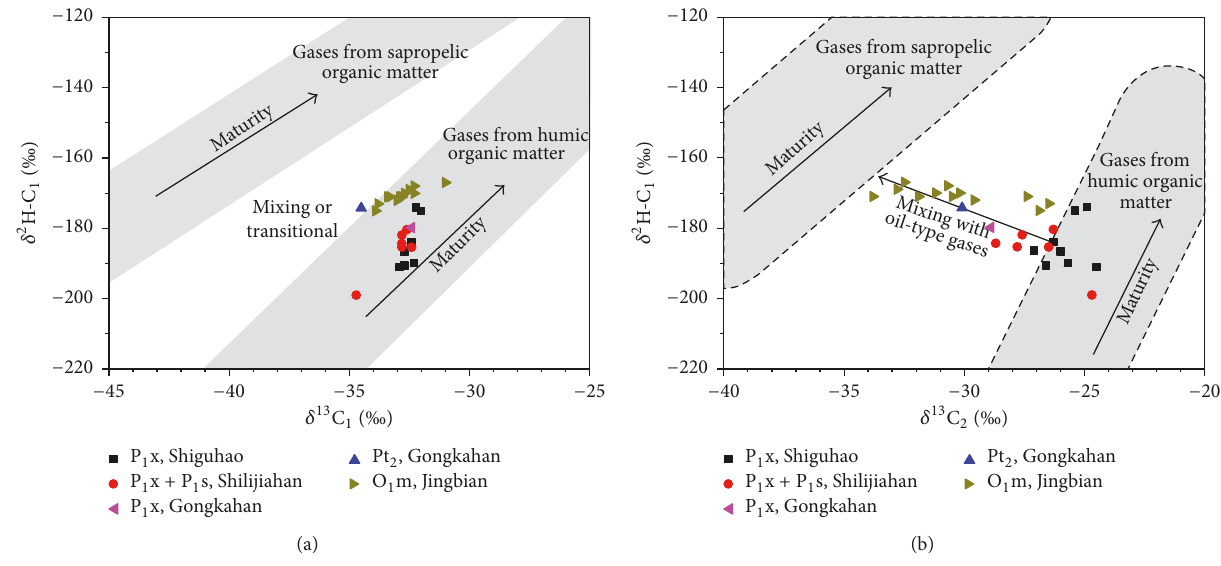
Figure 9: Correlation diagrams of 𝛿 2 H-C 1 versus 𝛿 13 C 1 (a) and 𝛿 2 H-C 1 versus 𝛿 13 C 2 (b) of tight gas from the Hangjinqi area (modified after Wang et al. [13]). Data of the O 1 m gas in the Jingbian gas fields are from Dai